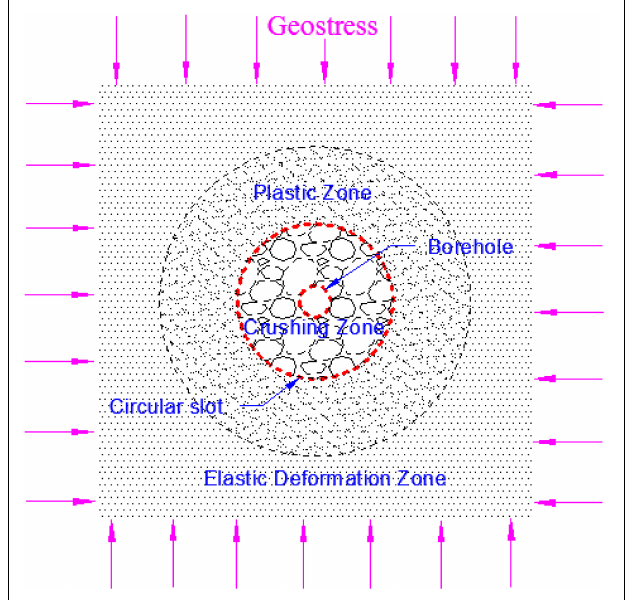
FIGURE 1 | Cross section of a vertical circular slot (plan